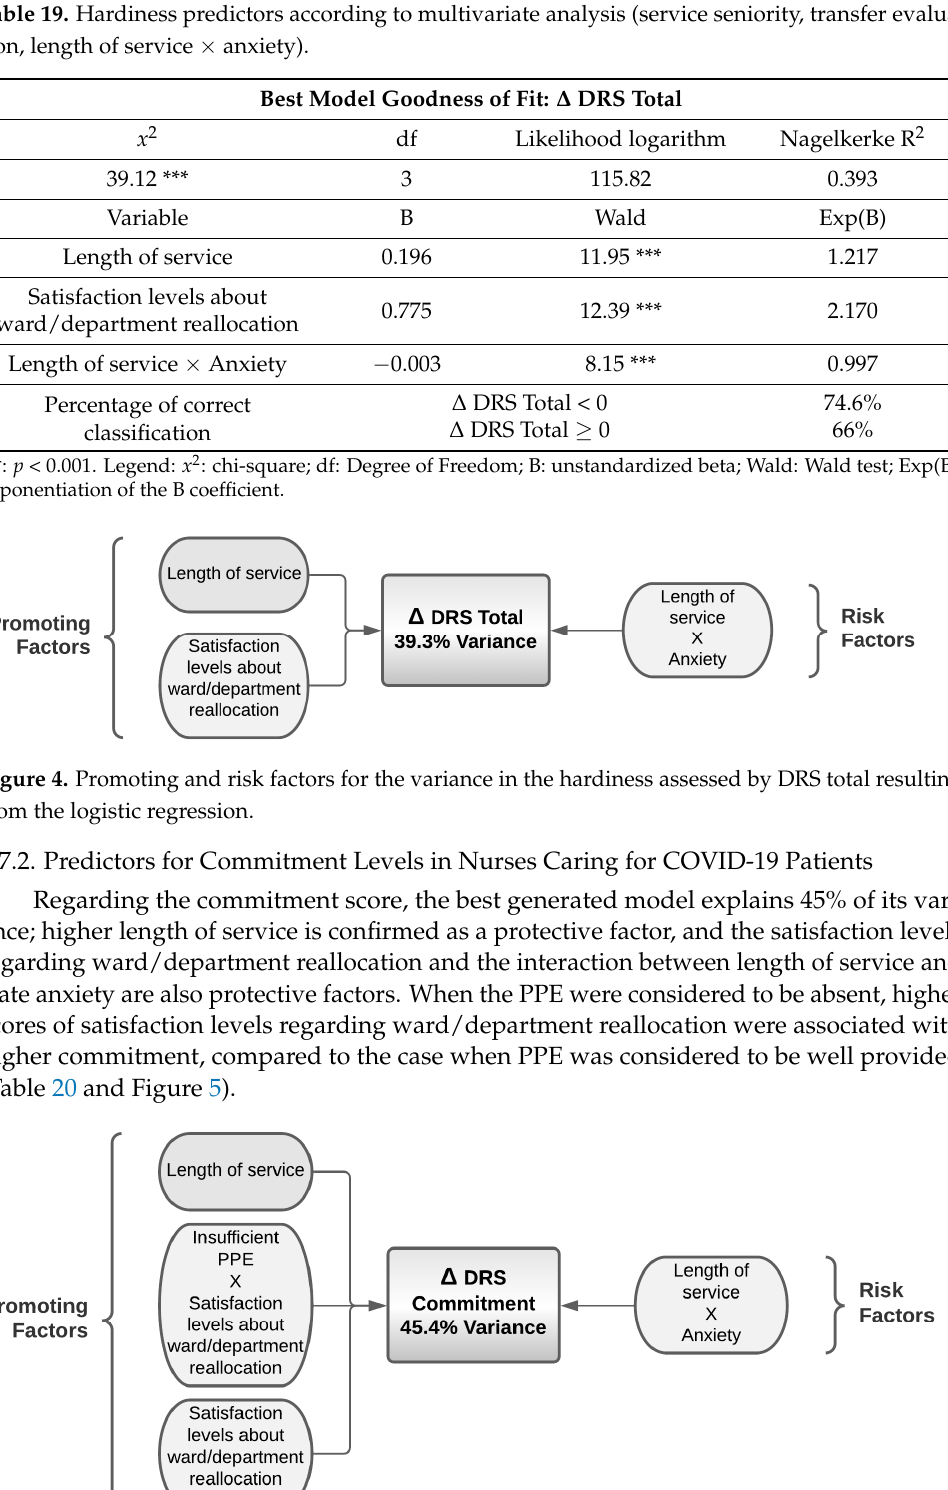
Table 19. Hardiness predictors according to multivariate analysis (service seniority, transfer evaluation, length of service × anxiety).